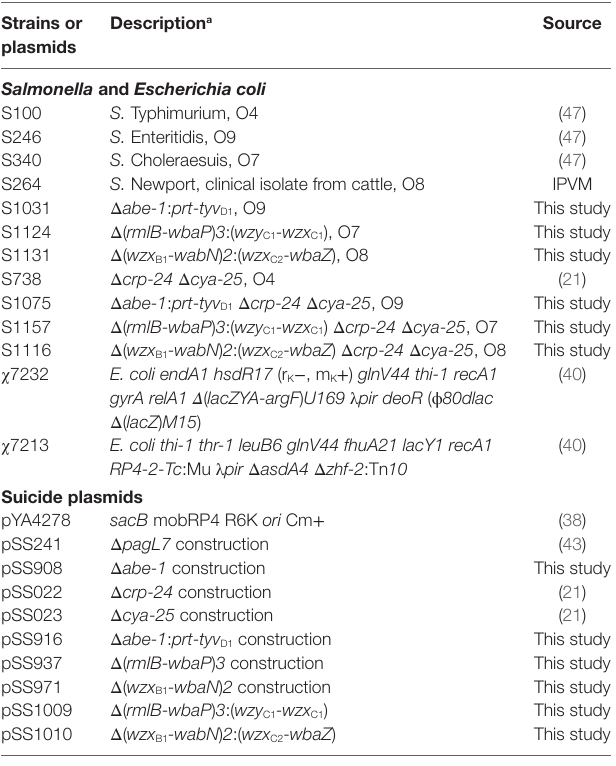
TaBle 1 | Bacterial strains and plasmids used in this study. strains or Description plasmids